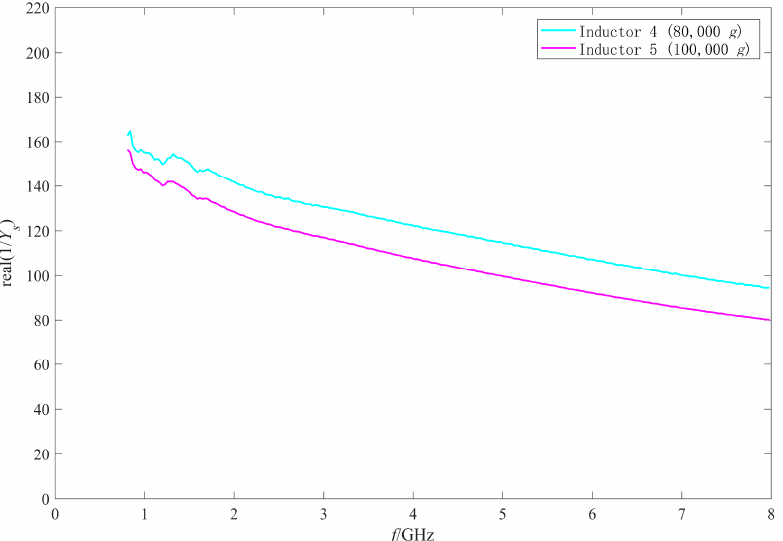
Figure 23. The real part of 𝑌 (cid:3046) of the failed inductors after shock test.